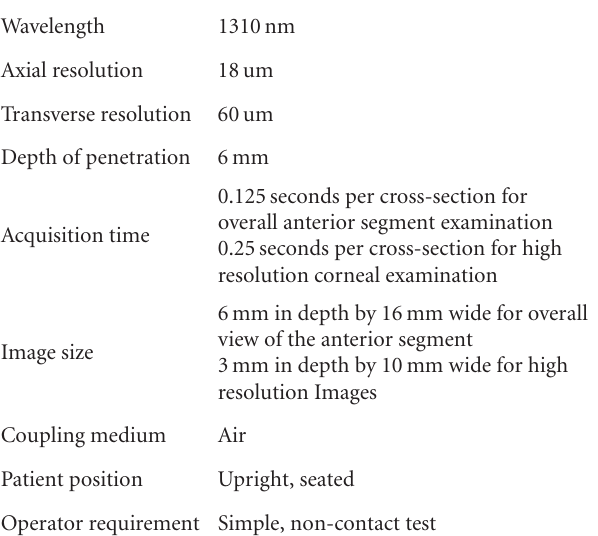
Table 1: The visante AS-OCT (anterior segment optical coherence tomography) properties.